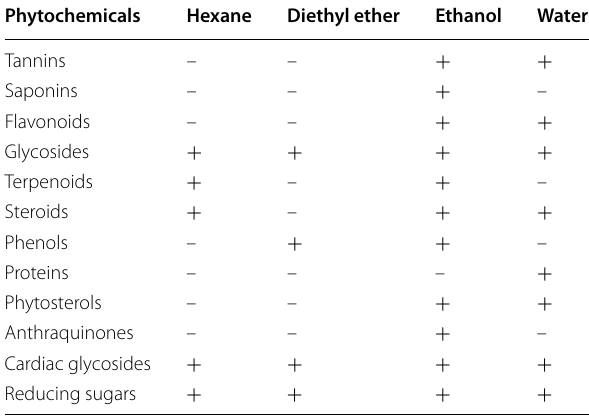
Table 1 Phytochemical Screening of various leaf extracts